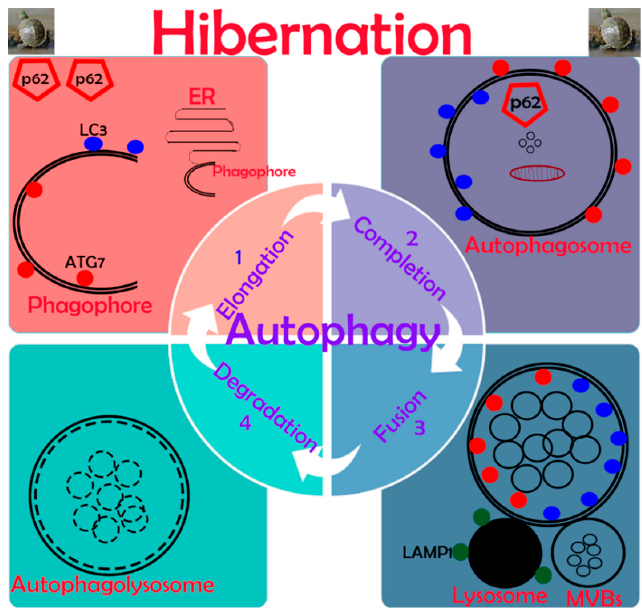
Figure 9. Schematic diagram of autophagy in enterocytes of the small intestine in P. sinensis during hibernation.